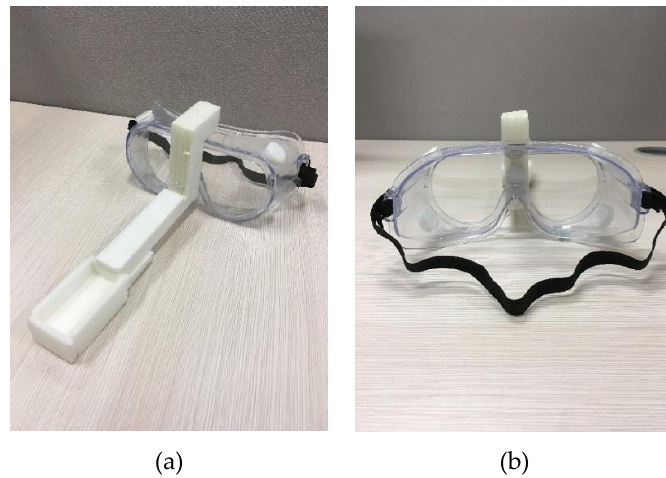
Figure 3. Equipment for real-world practice. ( a ) A view from the front. ( b ) A view from the